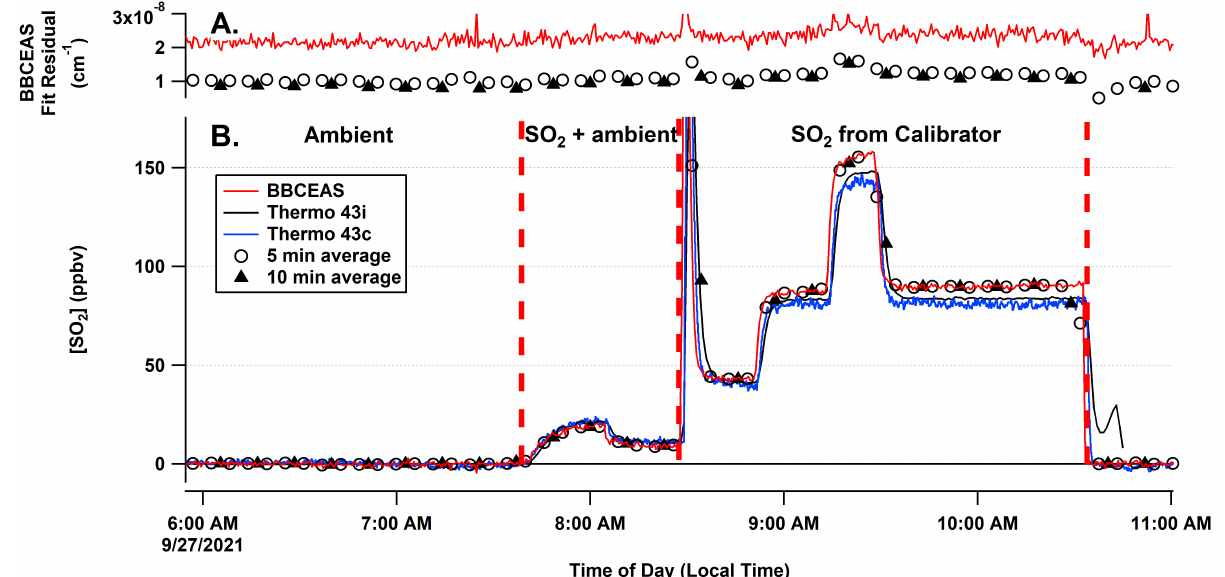
Figure 6. Time series of retrieved SO 2 concentrations. Panel ( A ) shows the 1- σ standard deviation of the fit residual for the 30 s, 5 min, and 10 min data. Panel ( B ) shows the measured SO 2 from the three instruments under ambient, SO 2 + ambient, and calibration conditions as well as the time traces for the 5 and 10 min averaged data. Vertical red dashed lines separate the different conditions. The jump in the 43i signal at the end of the experiment is due to a flow connection change to that